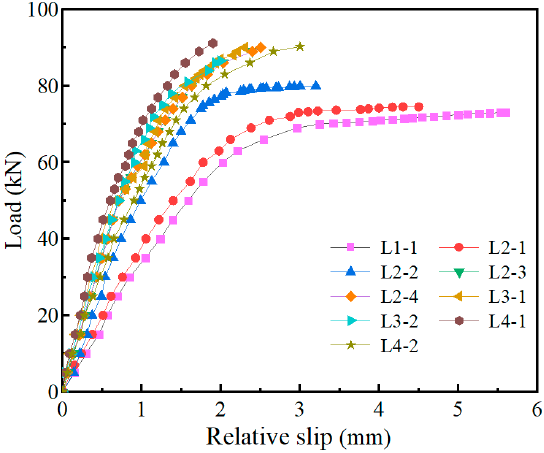
Figure 12. The load–slip curve.